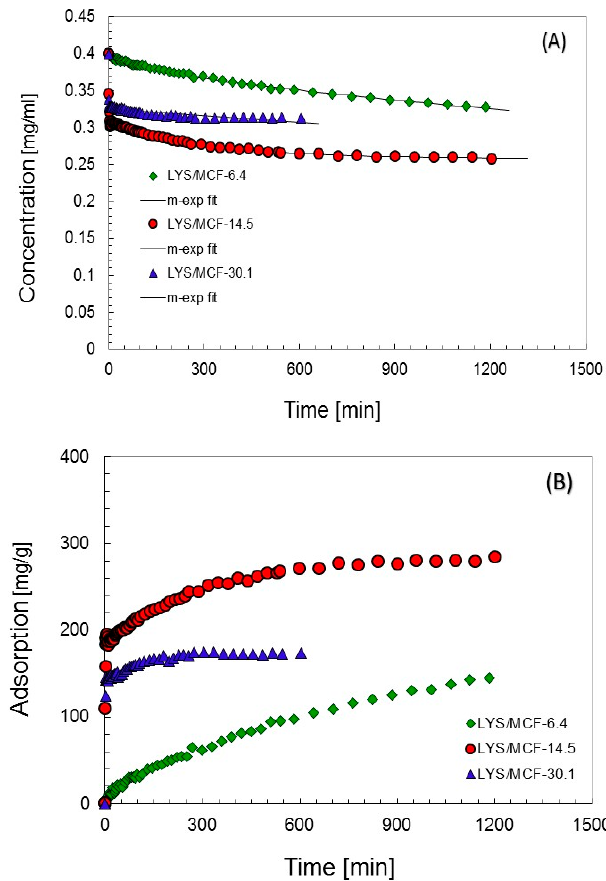
Figure 2. The comparison of concentration ( A ) and adsorption ( B ) profiles measured for lysozyme adsorption on MCF-14.5, MCF-6.4, and MCF-30.1 supports. Adsorption conditions: c 0 = 0.4 mg/mL, T = 25 ° C; pH = 7.4. Table 3. Optimized parameters of m-exp eq.